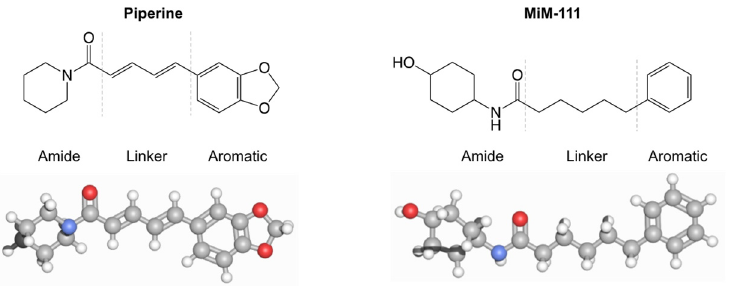
Figure 1. Comparative structures of piperine and a prototype mitofusin activator. ( top ) 2-dimensional structures without stereochemistry (ChemDraw). ( bottom ) 3-dimensional structures representing stereochemistry (ChemDoodle).